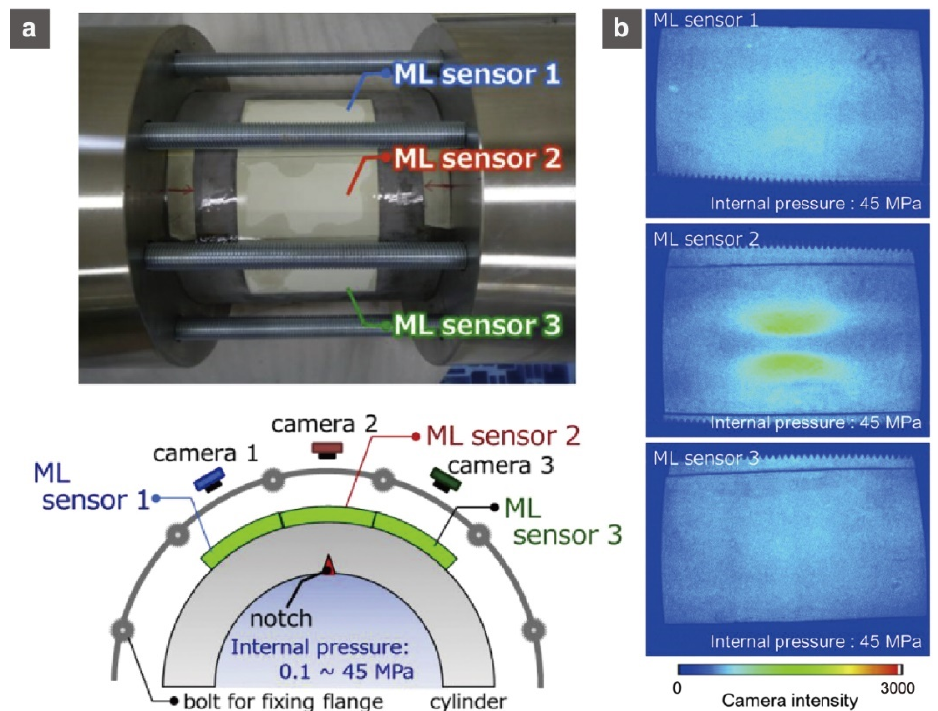
Figure 9. ( a ) Photograph of a storage cylinder with three attached mechanoluminescence